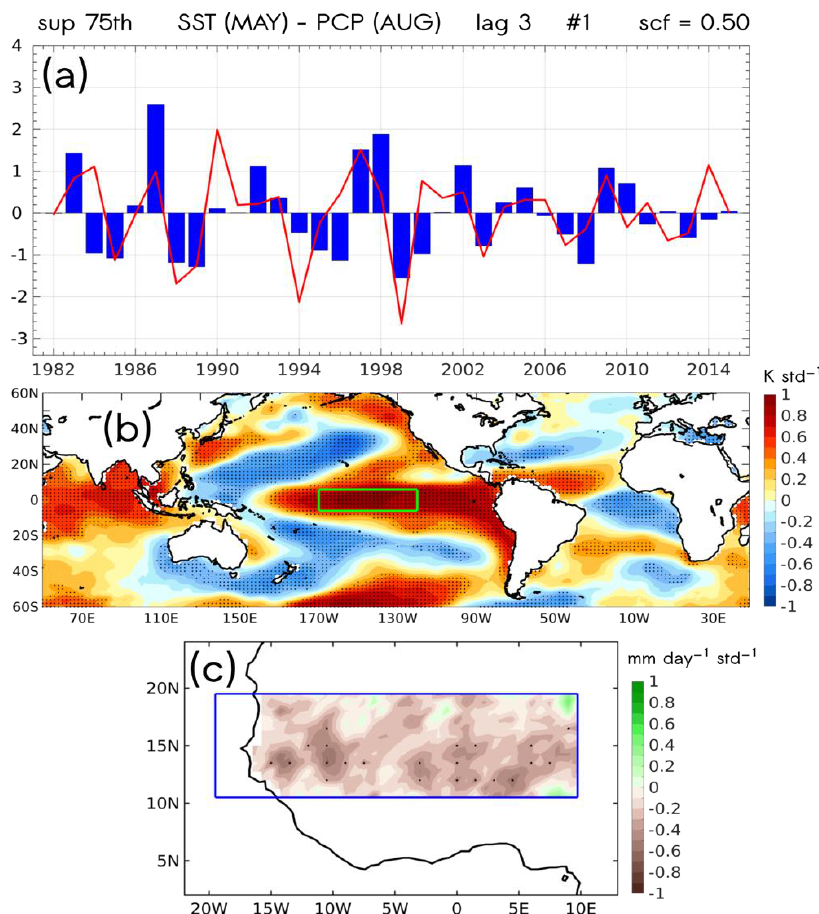
Figure 5. As in Figure 3 but with the leading MCA mode calculated between SSTA in the Niño 3.4 region (170°–120° W; 6° S–6° N) in MAY (lag 3) and the anomalous Sahel rainfall above the 75th (170 ◦ –120 ◦ W; 6 ◦ S–6 ◦ N) in MAY (lag 3) and the anomalous Sahel rainfall above the 75th percentile percentile in AUG. (a ) Time series expansion coefficients for SST (U; blue bars) and rainfall (V; red in AUG. (a ) Time series expansion coe ffi cients for SST (U; blue bars) and rainfall (V; red line) for the line) for the leading JUL-AUG MCA mode. ( b ) Homogeneous SSTA (K std − ¹) map calculated by leading JUL-AUG MCA mode. ( b ) Homogeneous SSTA (K std − 1 ) map calculated by regression of SST regression of SST expansion coefficient U onto global SSTA. Green contoured box denotes the region expansion coe ffi cient U onto global SSTA. Green contoured box denotes the region taken into account taken into account for MCA. ( c ) Heterogeneous map of anomalous rainfall (mm day − ¹ std − ¹) calculated for MCA. ( c ) Heterogeneous map of anomalous rainfall (mm day − 1 std − 1 ) calculated by regression of by regression of SST expansion coefficient U onto regional anomalous Sahelian rainfall. SST expansion coe ffi cient U onto regional anomalous Sahelian